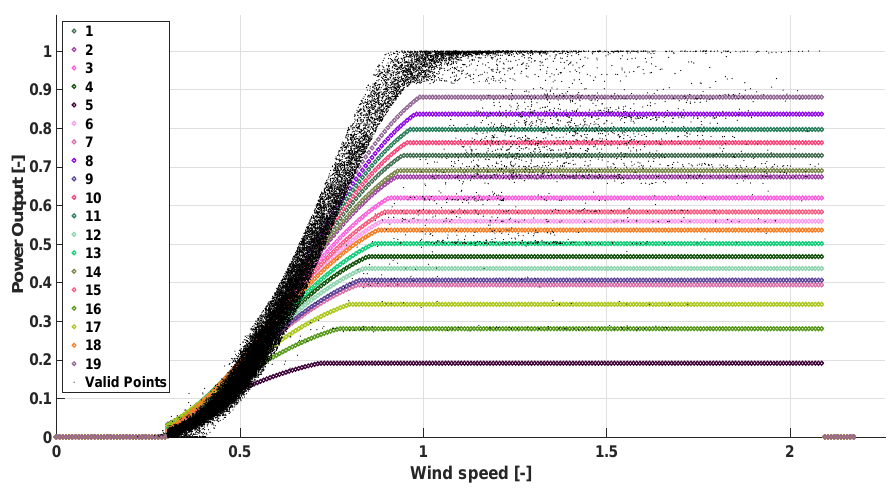
Figure 6. Final Extracted Points from raw data by applying the proposed